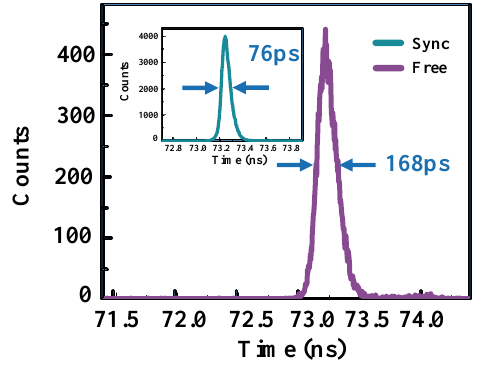
Figure 4. Timing jitter of the SPAD in the free-running mode. Inset: Timing jitter of the SPAD in the synchronously gating mode with the detection efficiency of 10.0%.